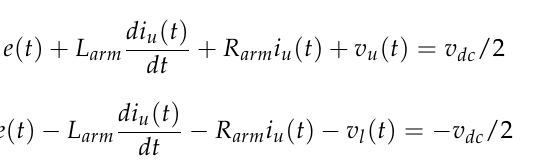
Σ ( t ) are obtained as: Cu , l